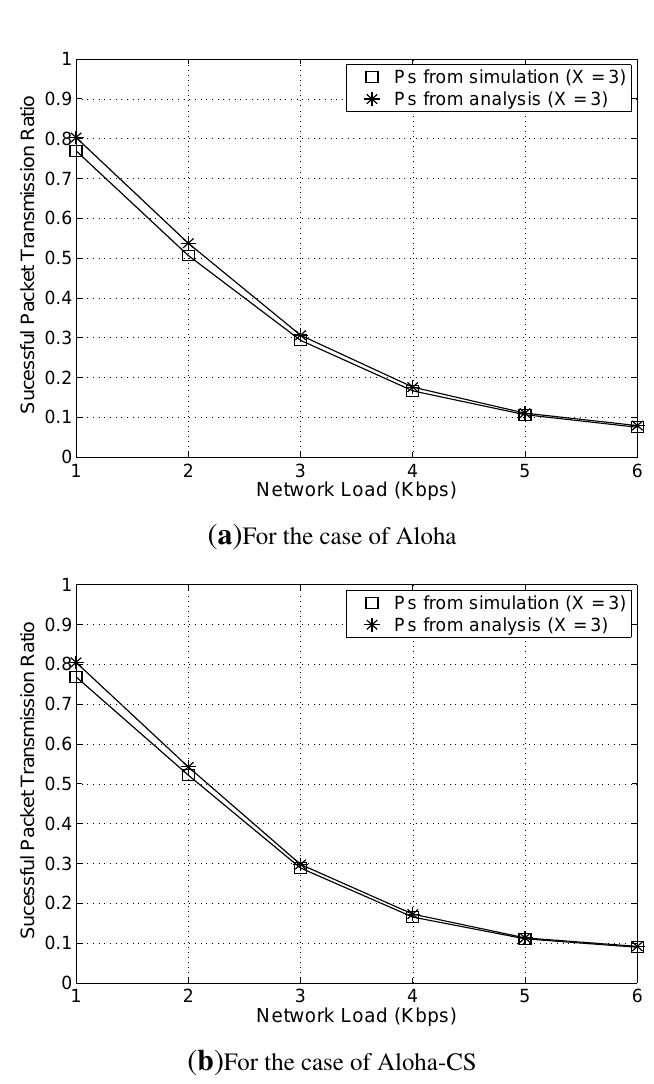
Figure 2. Approximation of the successful packet transmission ratio. Aloha-CS, Aloha with carrier